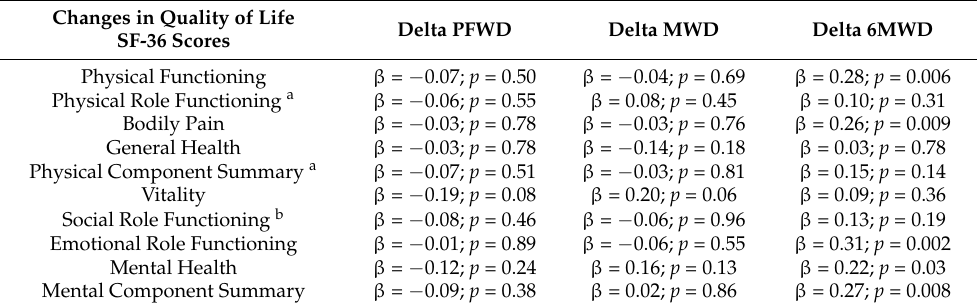
Table 5. Changes in treadmill performance and 6 min walking distance and their relationship to changes in health-related quality of life following supervised exercise training without multiple imputations.